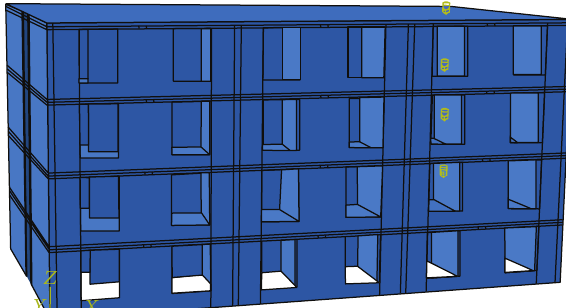
Figure 7: Model 5 with structural columns (0.6 m).